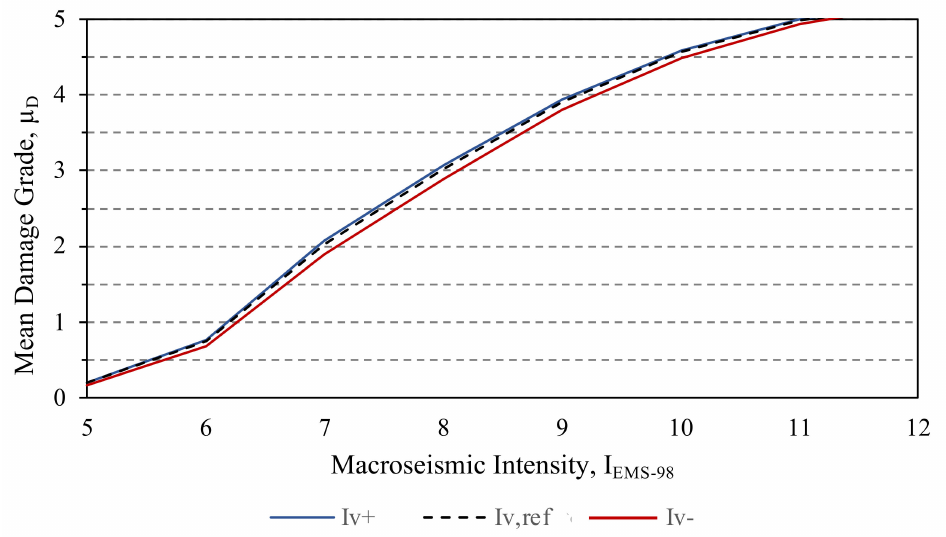
Figure 10. Vulnerability curves for the mean I + v = 44.15, I − v =39.15, and I v,ref = 42.88. This curve exem- plifies that the minimum and maximum values are reasonably close to reference values, supporting the hypothesis of having an accurate approach.